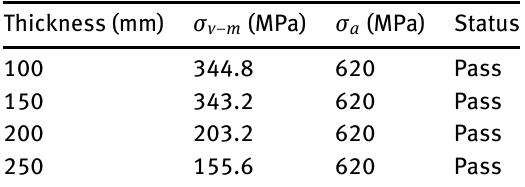
Table 6: Comparison of stress at various plate thicknesses.